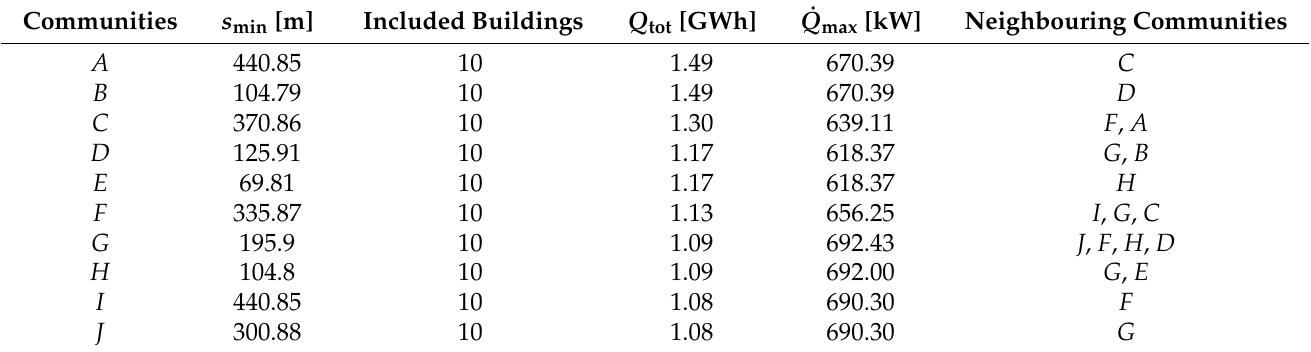
Table 6. Identified communities in the network structure of the generic district heating system.